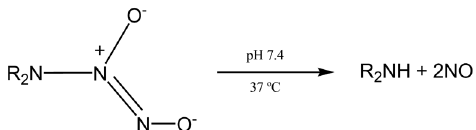
FIGURE 7 - NO release from diazeniumdiolate under physiological